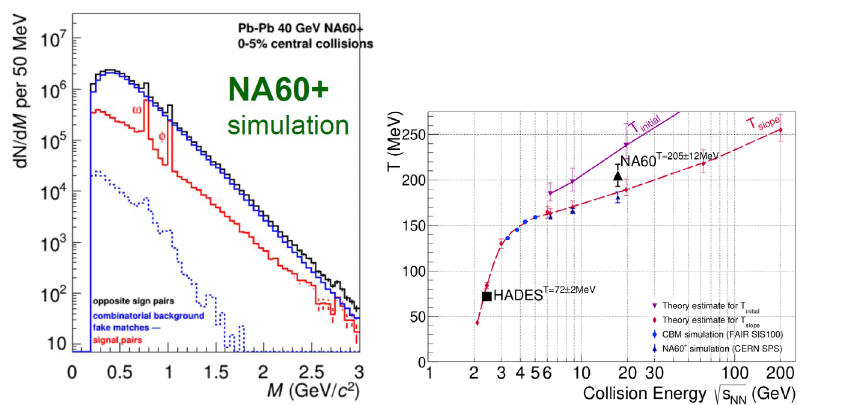
Figure 3. Left: simulated dimuon mass spectrum in central Pb-Pb collisions at E = 40 GeV per nucleon. Right: medium temperature evolution vs √ s NN in central Pb-Pb